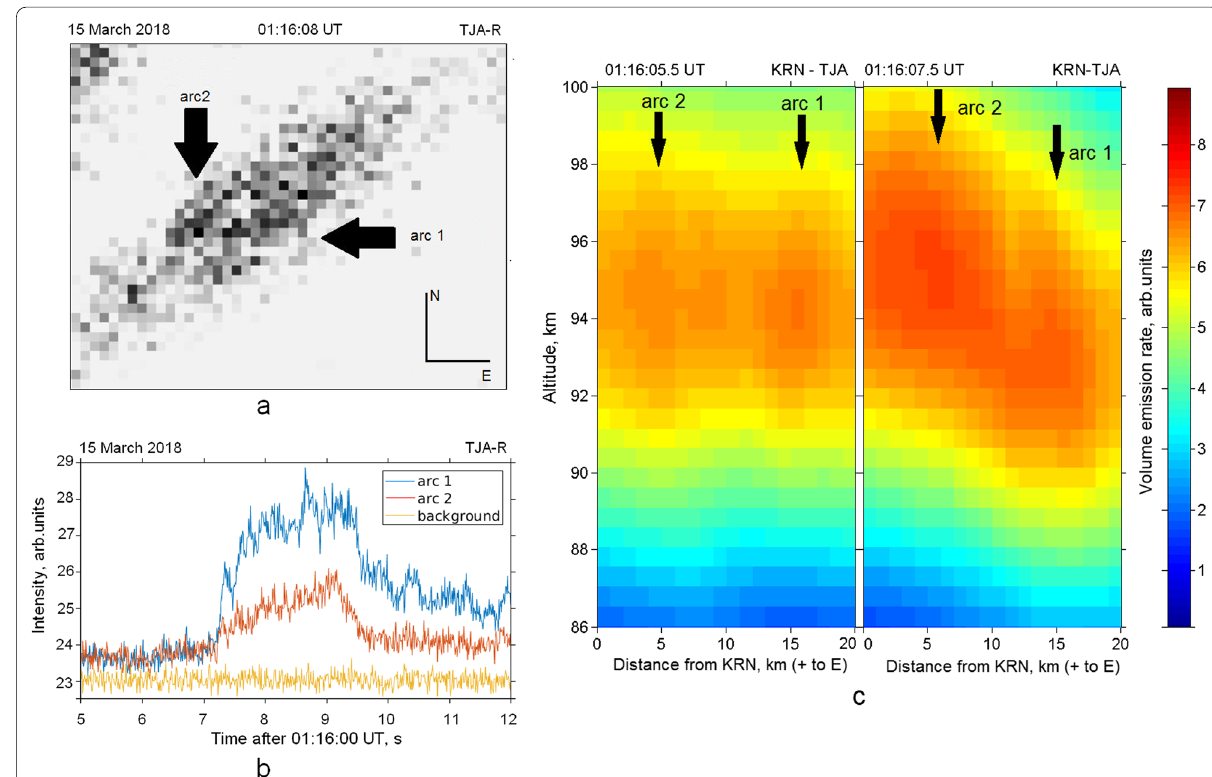
Fig. 6 a Fine structure of the pulsating arc shown in Fig. 1a; b luminosity variations in the arcs and background for the first switch‑on interval (Fig. 1b); c altitude distribution of arc luminosity before (left panel) and during (right panel) the